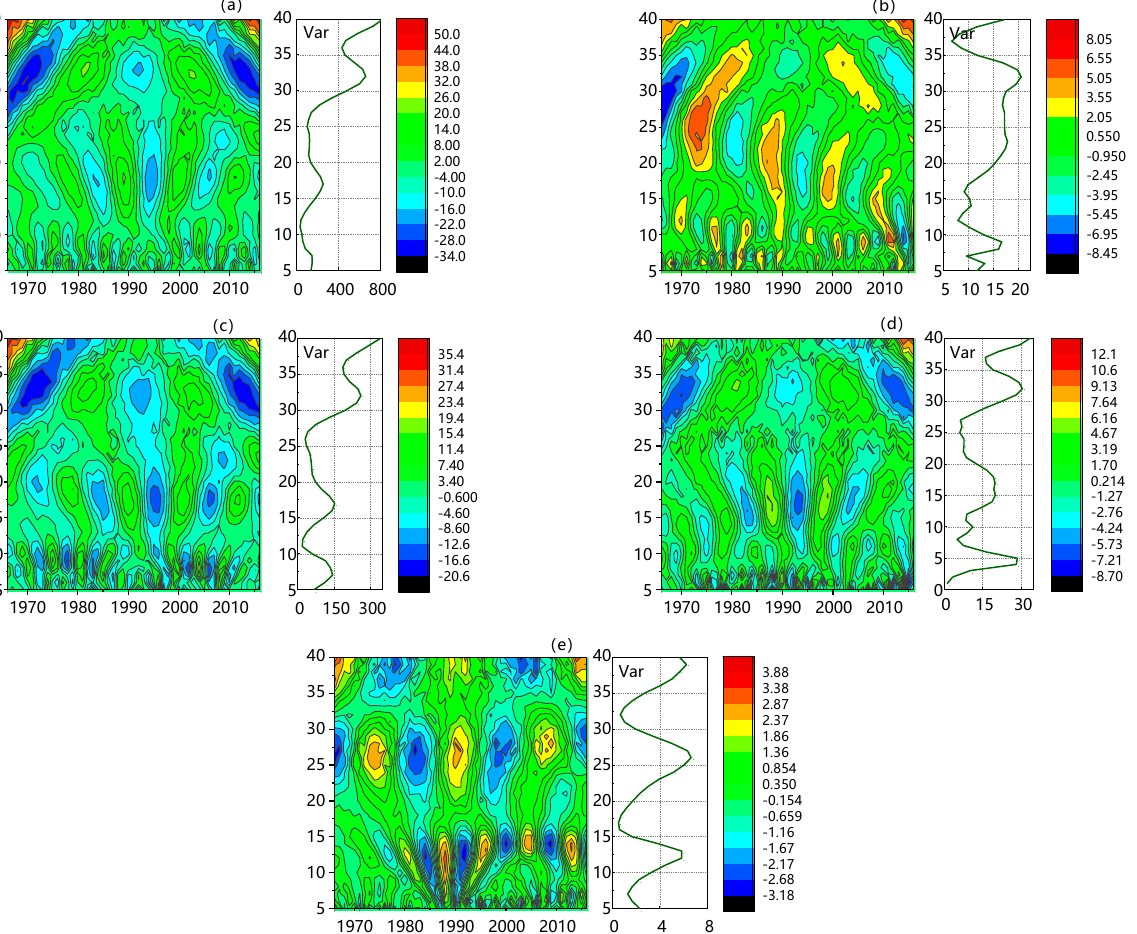
Figure 5. Wavelet variance of the annual and seasonal precipitation series and a contour map of the real part of wavelet coefficients in the TP area in 1966–2016. ( a ) Annual, ( b ) spring, ( c ) summer, ( d ) autumn, ( e ) winter.